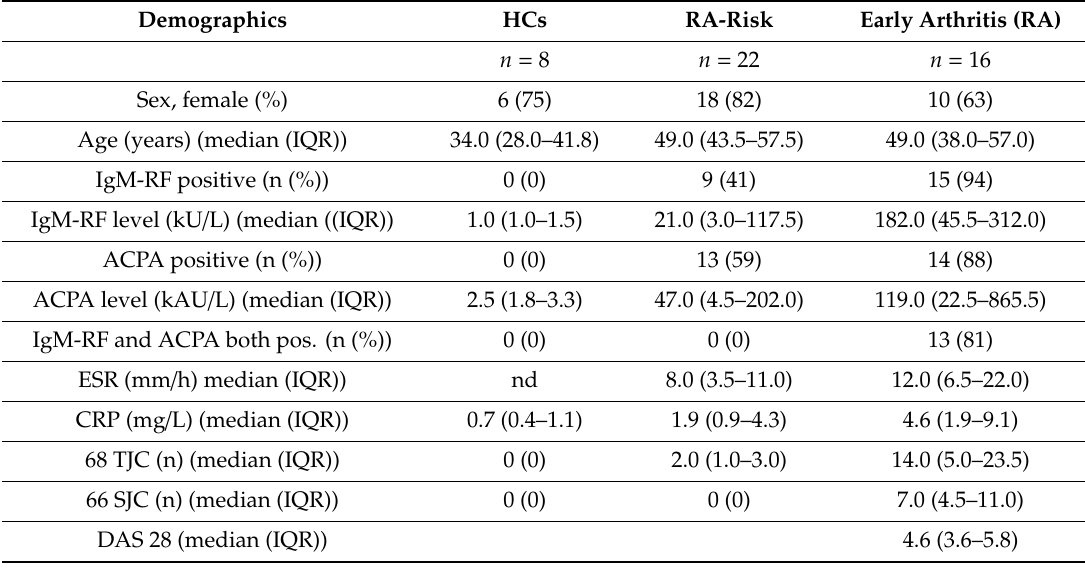
Table 1. Baseline characteristics of healthy controls (HCs), rheumatoid arthritis (RA)-risk individuals and early-RA patients. Categorical variables: n (%). Continuous variables (data not normally distributed): median interquartile range (IQR). ACPA, anticitrullinated protein antibodies; ESR, erythrocyte sedimentation rate; CRP, C-reactive protein; IgM-RF, IgM rheumatoid factor; 68 TJC, tender joint count of 68 joints; 66 SJC, swollen joint count of 66 joints; DAS, disease activity score; nd, not done. Demographics